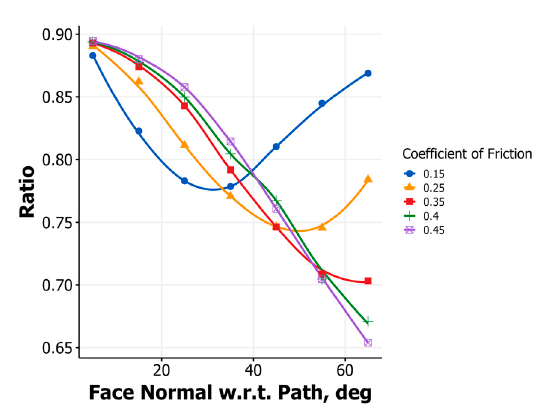
Figure 6. Launch direction ratio vs. face normal relative to club path for various coefficients of friction for an incident velocity of 80 mph.